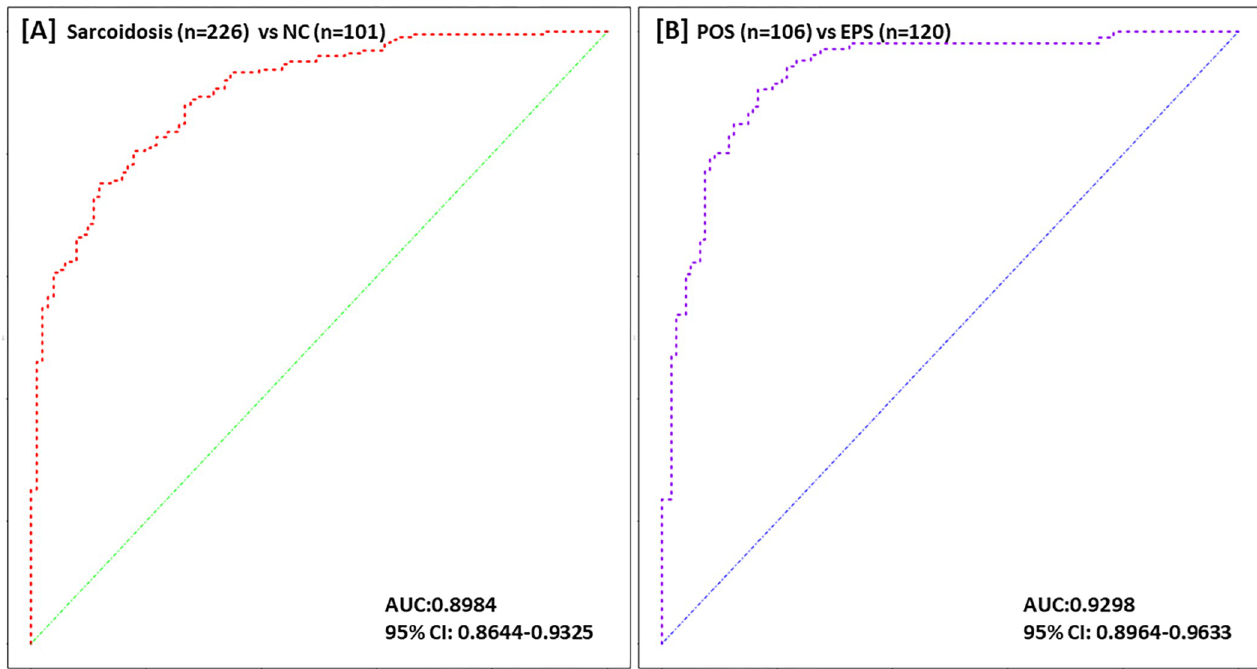
Fig 4. [A] ROC plots of 11 IgM autoantibodies are used as biomarkers to distinguish sarcoidosis (n = 226) from NC (n = 101) [B] ROC plots of 8 IgM autoantibodies can be applied to differentiate EPS from